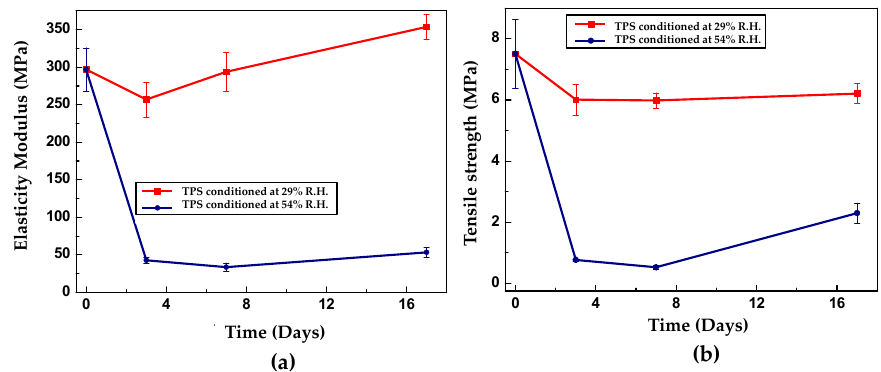
Figure 9. Tensile mechanical properties for TPS as a function of storage time at 25 °C and relative humidity of 54 and 29%. ( a ) Modulus of elasticity and ( b ) maximum strength. Table 4. Tensile mechanical properties of different TPS samples under different storage conditions. Percentage calcu- lated with respect to the total mass (plasticizer + starch). Material Starch/Plasti- cizer